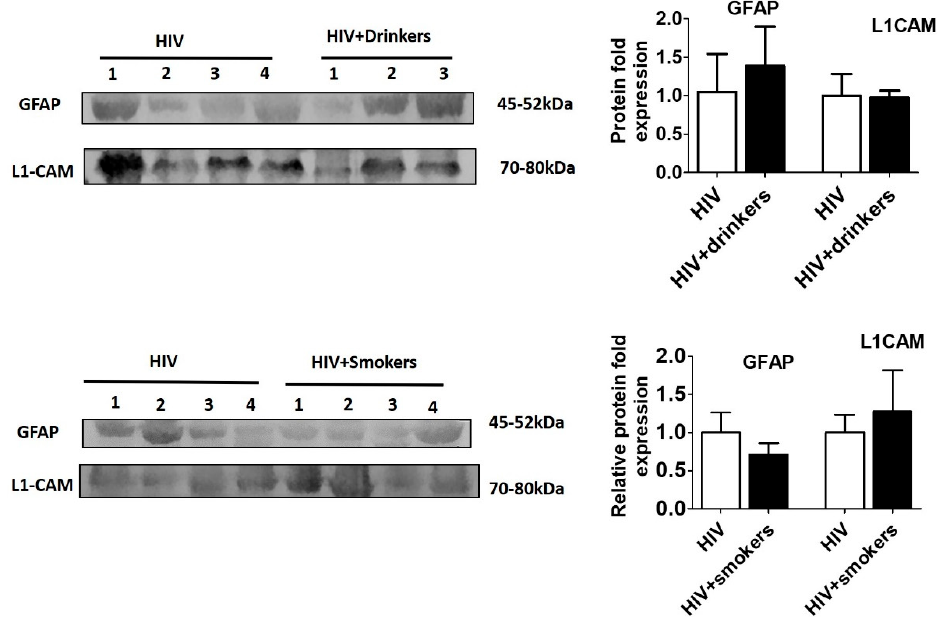
Figure 4. Expression of neuronal and astrocyte proteins in plasma EVs of HIV-positive subjects with and without substance use. EVs were isolated from plasma of HIV ( n = 4), HIV-positive drinkers ( n = 3), and HIV-smokers ( n = 4). Equal amounts of EV protein were loaded to analyze the expression of GFAP and L1CAM proteins. There were no significant differences in the expression of the proteins between HIV and HIV-positive substance users. p < 0.05 is considered significant.